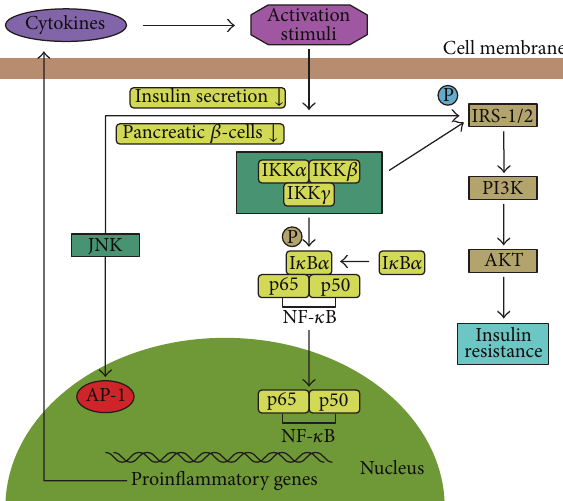
Figure 2: Inflammatory pathways linking inflammation to insulin resistance. Activation of JNK and NF- 𝜅 B pathways causes serine kinase phosphorylation of IRS-1 or IRS-2, which may block insulin signaling and finally lead to the occurrence of IR. In addition, JNK and NF- 𝜅 B pathways are involved in the production of proinflammatory cytokines which may in turn become activation stimuli of the